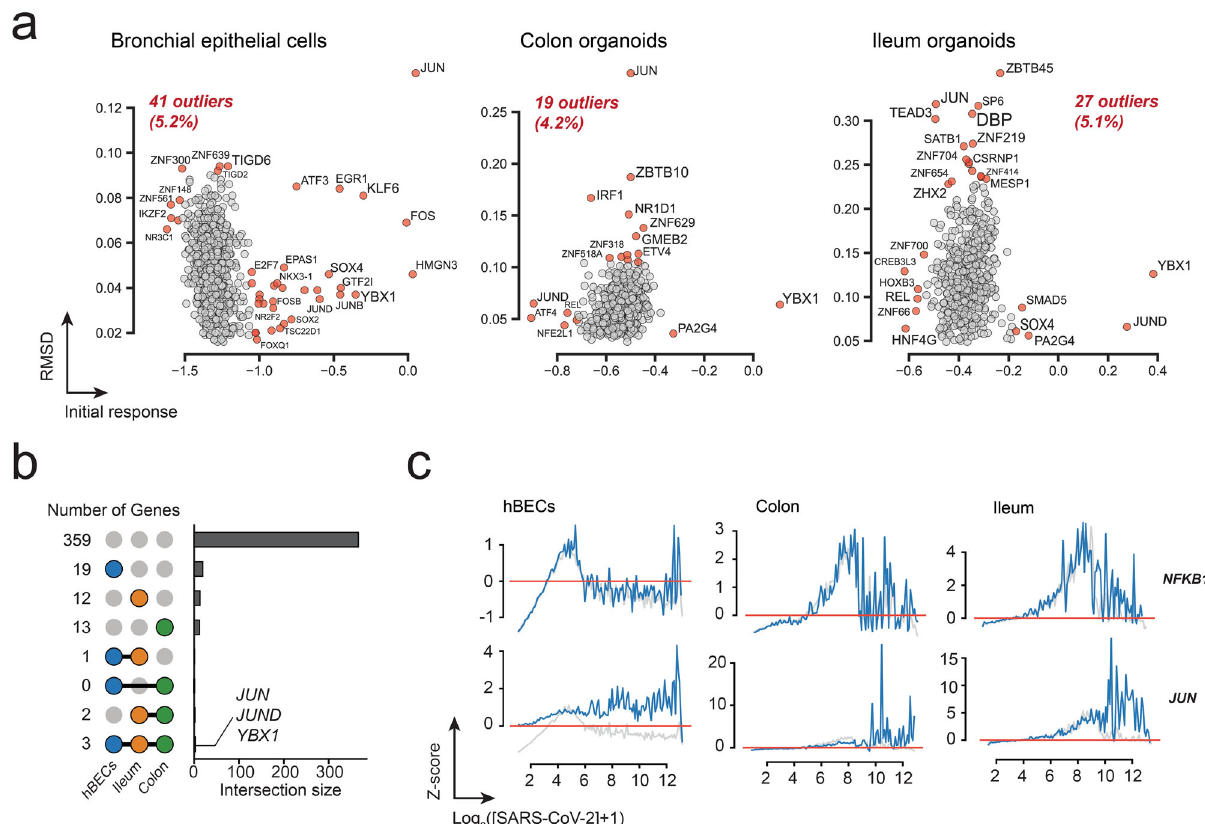
Fig. 4 Global transcriptional response transcription factors. a Distribution of transcriptional responses of identi fi ed transcription factors from hBECs, colon, and ileum datasets. Outliers are colored red. b Upset plots illustrating the number of outlier IFs shared among the three datasets. Most TFs (359) were common to the three datasets and exhibited an average response. The three TFs exhibiting a differential response to SARS-CoV-2 infections in the three cell types are indicated. c Representative examples of TFs exhibiting average ( NFKB1 ) and abnormal ( JUN ) transcriptional